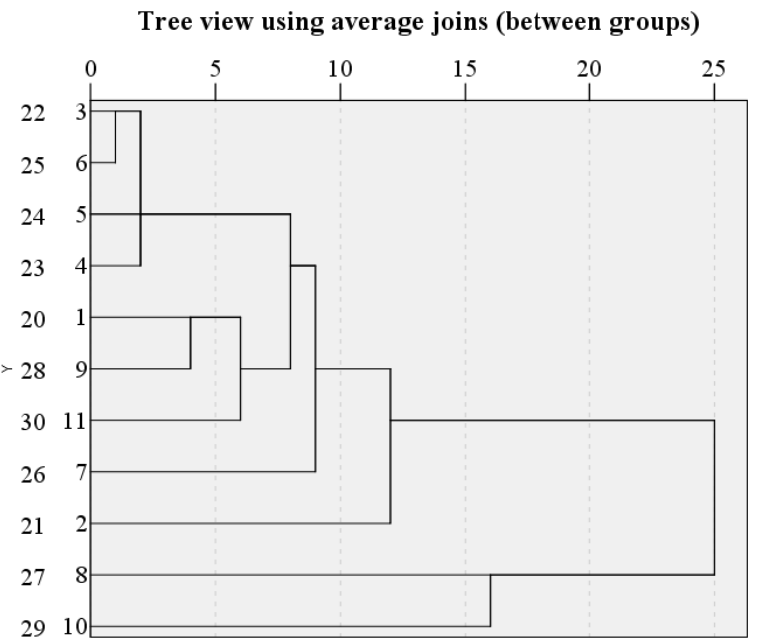
Figure 14. Cluster analysis of Ordovician limestone water system.